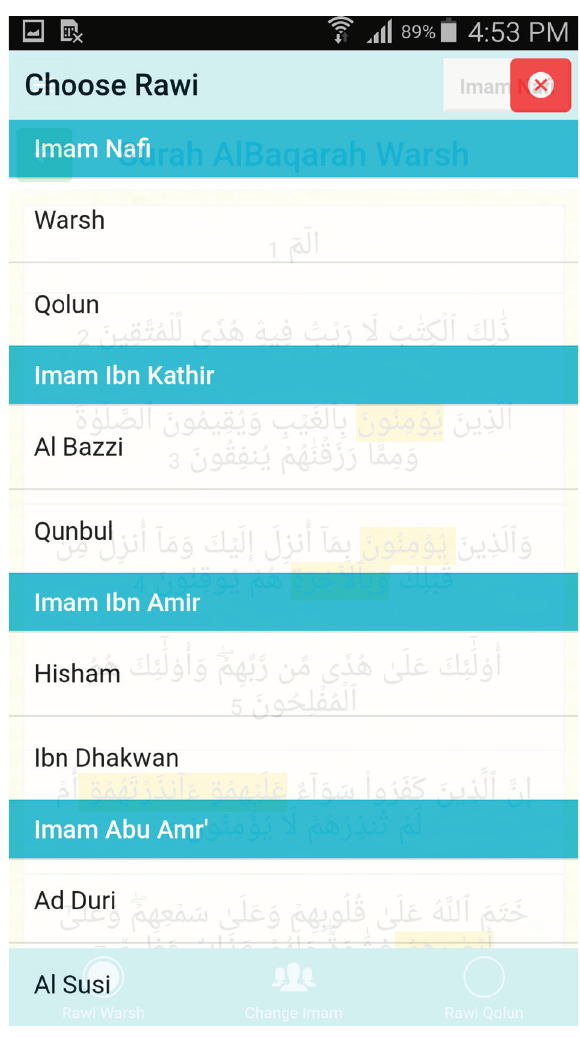
Figure 7: Option for choosing the reciter.